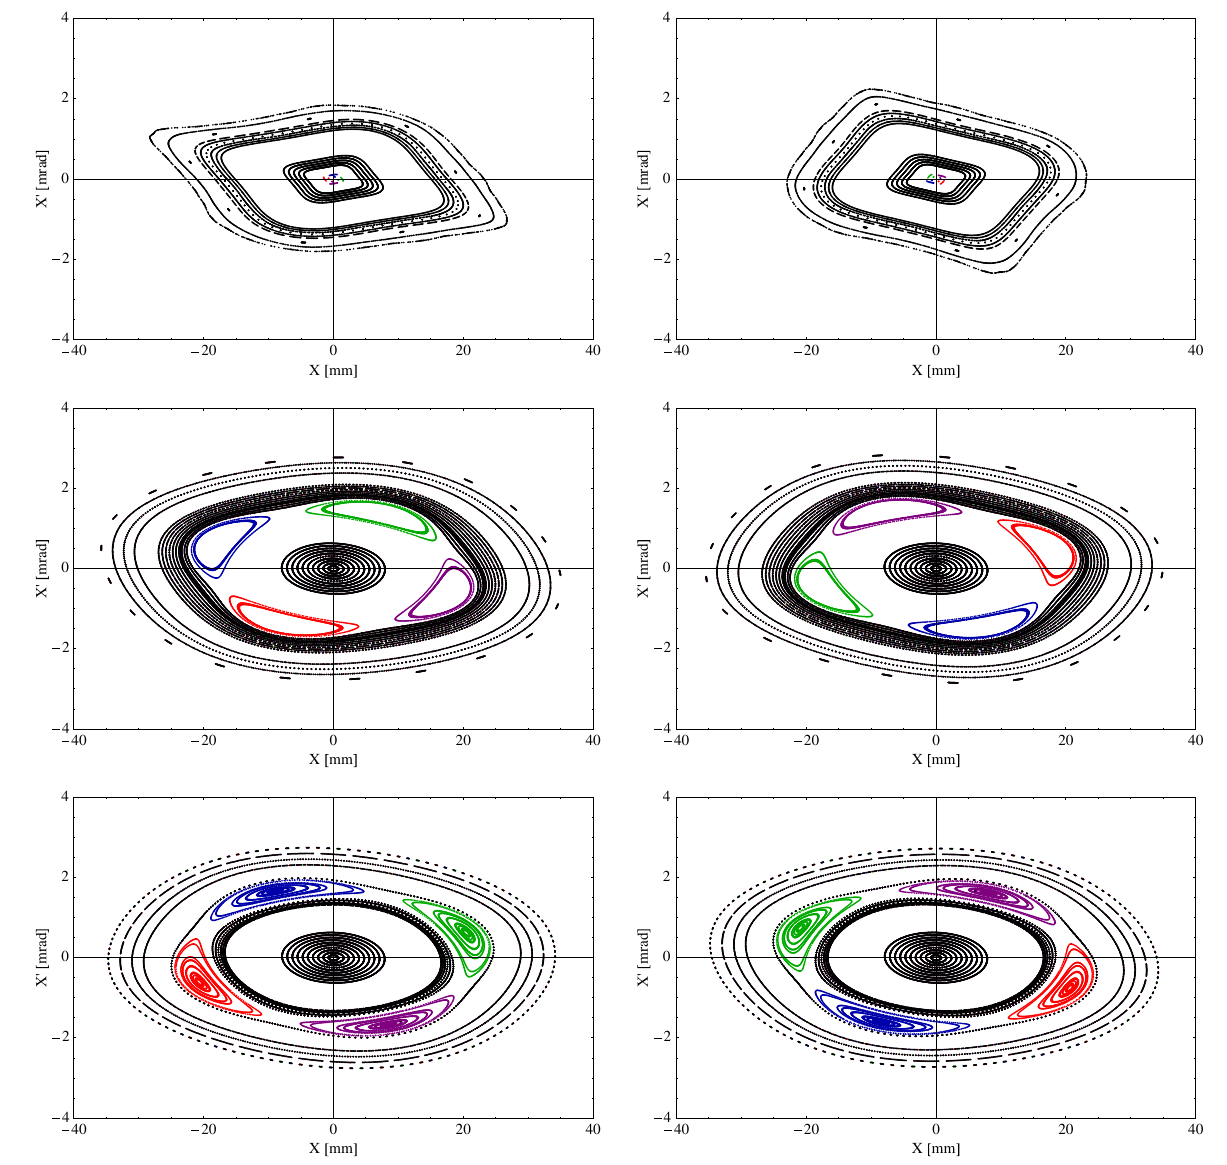
FIG. 3. Overview of the evolution of the phase space topology during the resonance crossing process. The two columns refer to the locations used for the first (left) and the second (right) experimental campaign, respectively. The location of the wire scanner used in 2012 is downstream with respect to the location in 2010. In their path from the upstream to the downstream, section particles in one island move into the island marked with the same color. The upper plot refers to the initial situation at 0.72 s from the beginning of the magnetic cycle, when islands are very small at the center of phase space. The center plot refers to the situation when the beam is already trapped inside the islands, 0.815 s from the beginning of the magnetic cycle. The last plot refers to the situation just prior to extraction after 0.835 s from the beginning of the magnetic cycle. The change in islands’ phase between the center and the bottom plot is due to the special circuit of octupoles used to correct the nonlinear coupling term h 1 ; 1